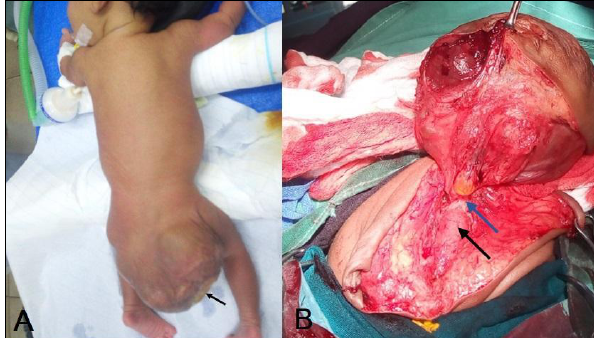
Figure 1: A) Clinical view of the sacrococcygeal mass. Note an ulcerated zone (black arrow) due to maneuvers during labor. B) Intraoperative view. Aspect after dissection of the mass, with intact posterior rectal wall, with its fascia (black arrow) and the coccyx (blue arrow), prior to its resection, along with the